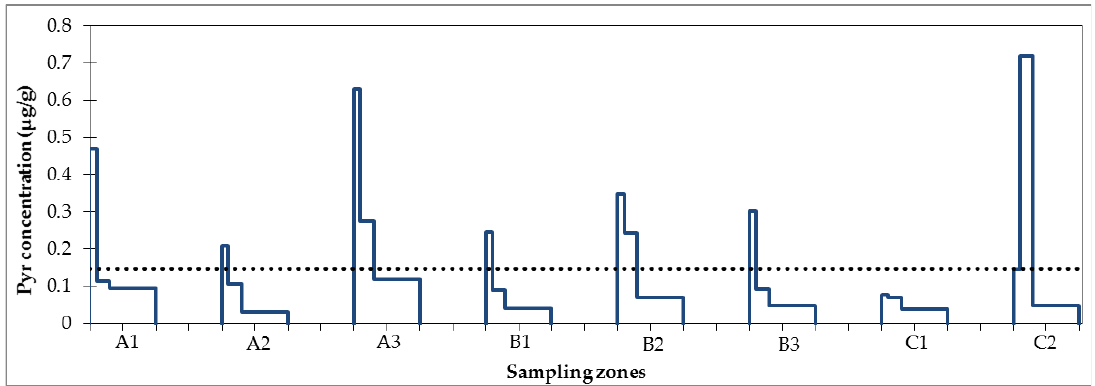
Figure D3. Concentrations of phenanthrene measured in composite cores of each sampling zone. Within each zone, concentrations from cores taken at depths of 0–5 cm, 5–15 cm and 15–50 cm are represented to scale from left to right. The dotted line represents the concentration measured in the initial soil sample.